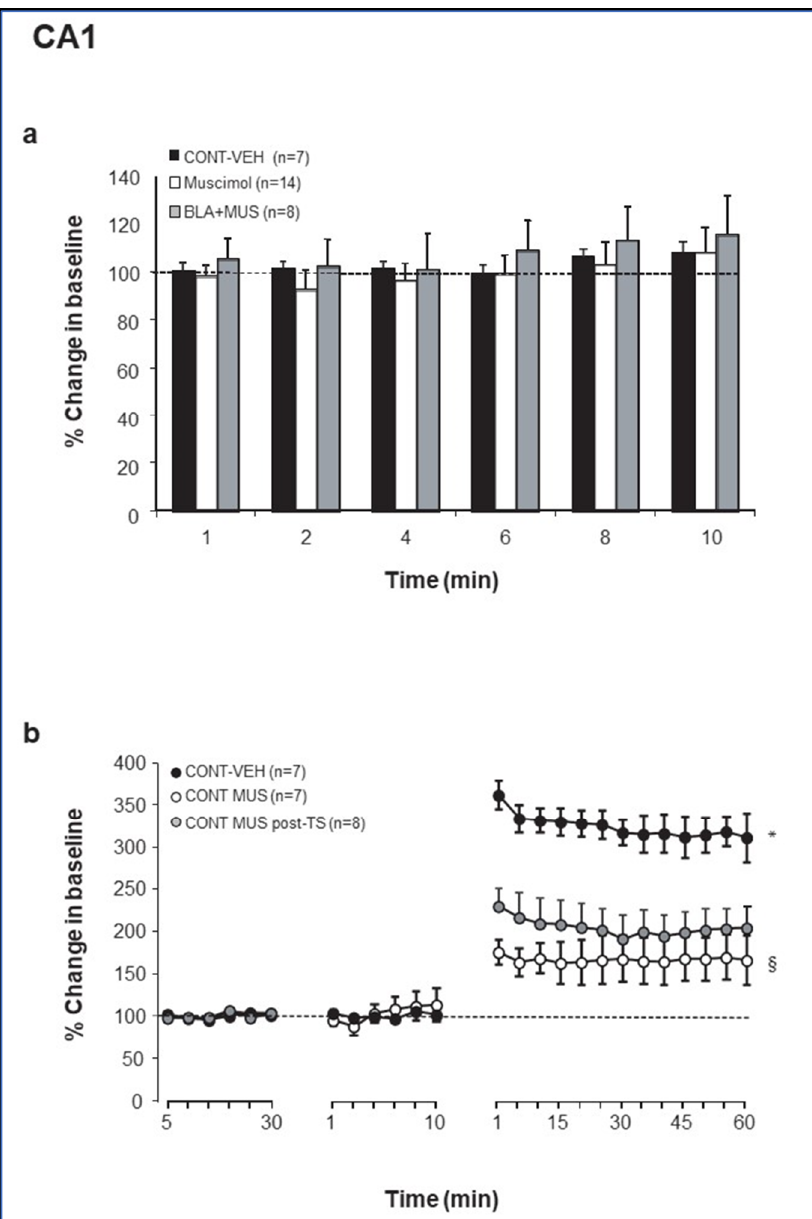
Figure 1. ( a ) Change in baseline excitationin the CA1 subregion following microinfusion of muscimol into the BLA. ns: not significantly different. (Muscimol— CONT-MUS and MUS - BLA (prior to BLA priming) groups). ( b ) Muscimol microinfused either before or after theta-like high-frequency stimulation (TS)-induced LTP suppressed LTP in the CA1. *, Control-VEH is significantly different from both Control-MUS-pre and Control-MUS-post ( p < 0.05). §, Control-MUS-pre is significantly different from Control-MUS-post ( p < 0.05).